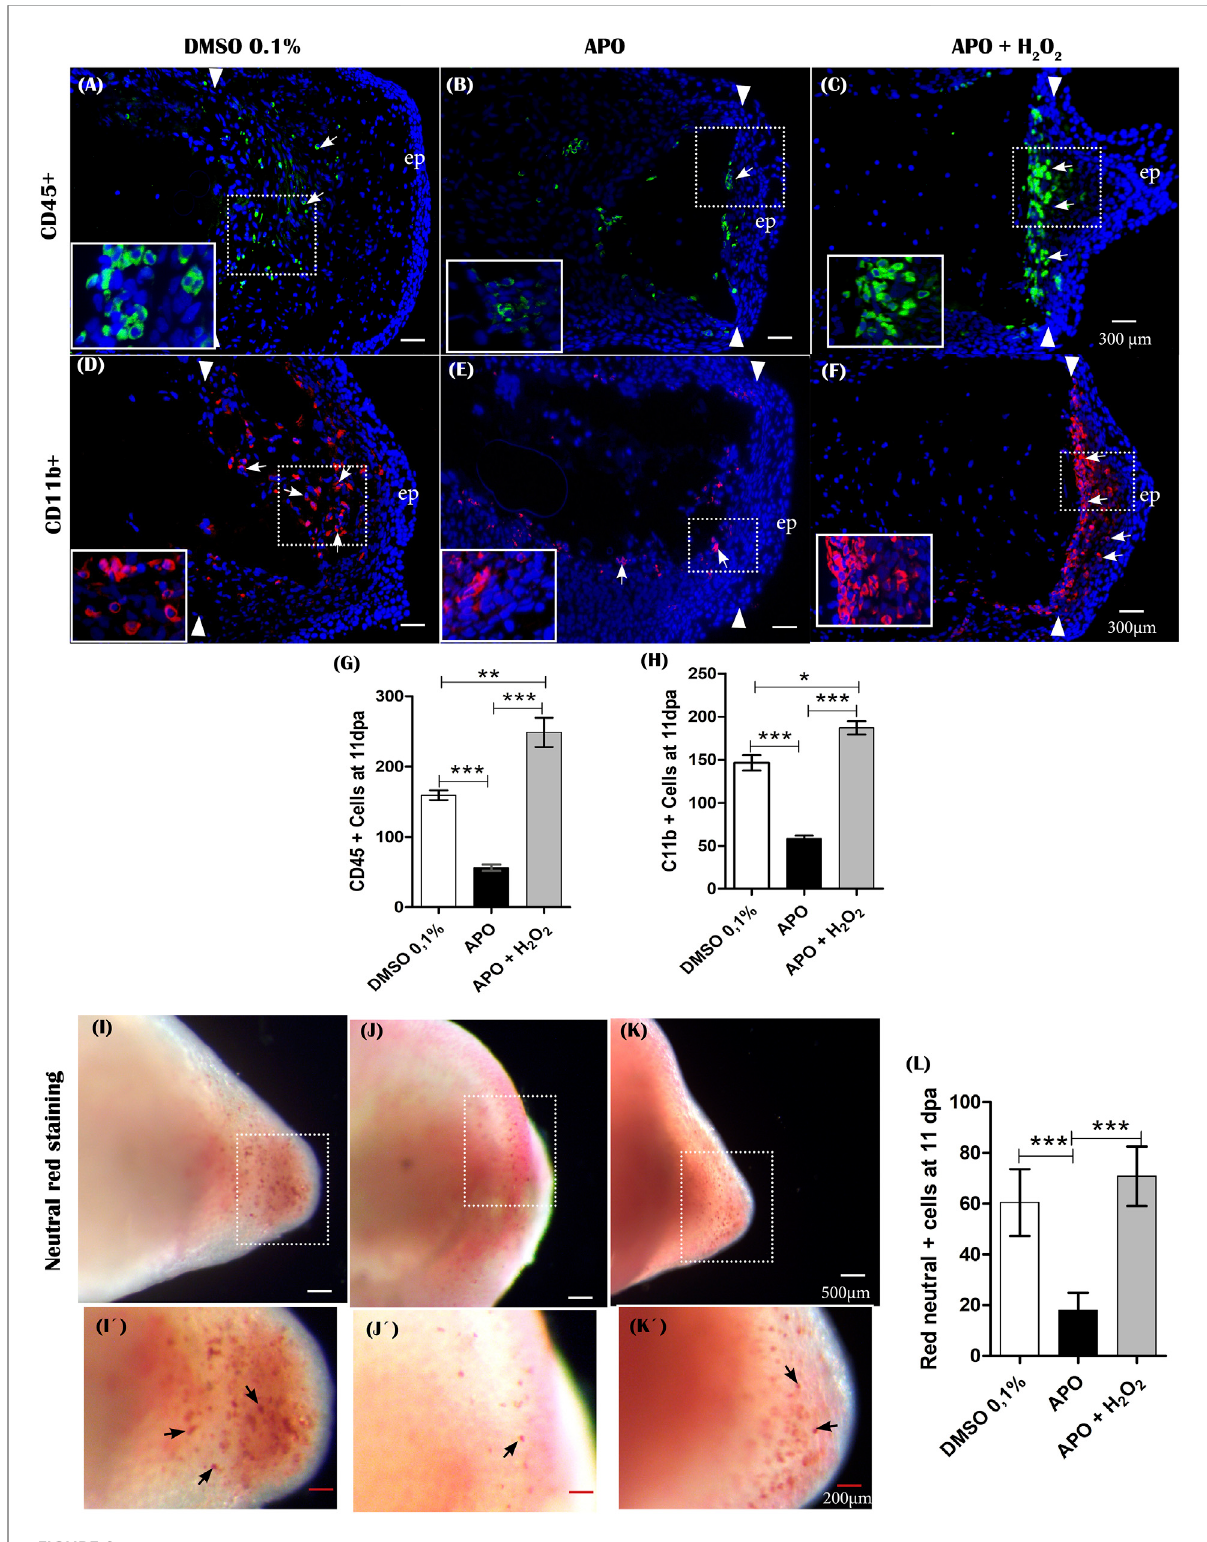
FIGURE 9 The production of ROS generated post-amputation of the limb is necessary for the recruitment and phagocytic activity of in fl ammatory cells. (A – C) , Representative immuno fl uorescence images against the leukocyte pan marker CD45 at 11 dpa. Boxes in white dotted lines are shown at